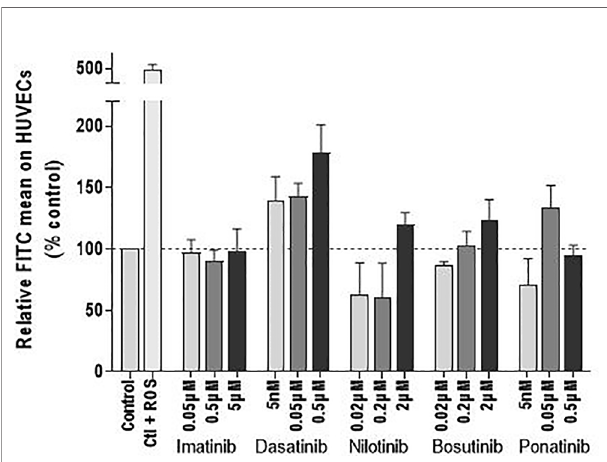
FIGURE 4 | BCR-ABL TKIs do not increase the ROS levels in HUVECs. ROS levels in HUVECs after treatment with BCR-ABL TKIs for 72 h in medium with 10% dialyzed FBS, expressed as intensity of FITC. Bars represent the means of three experiments ± SEM. Results are expressed relative to control (DMSO 0.2%). Differences between conditions were tested using a one sample t-test that compared each TKI condition versus control.